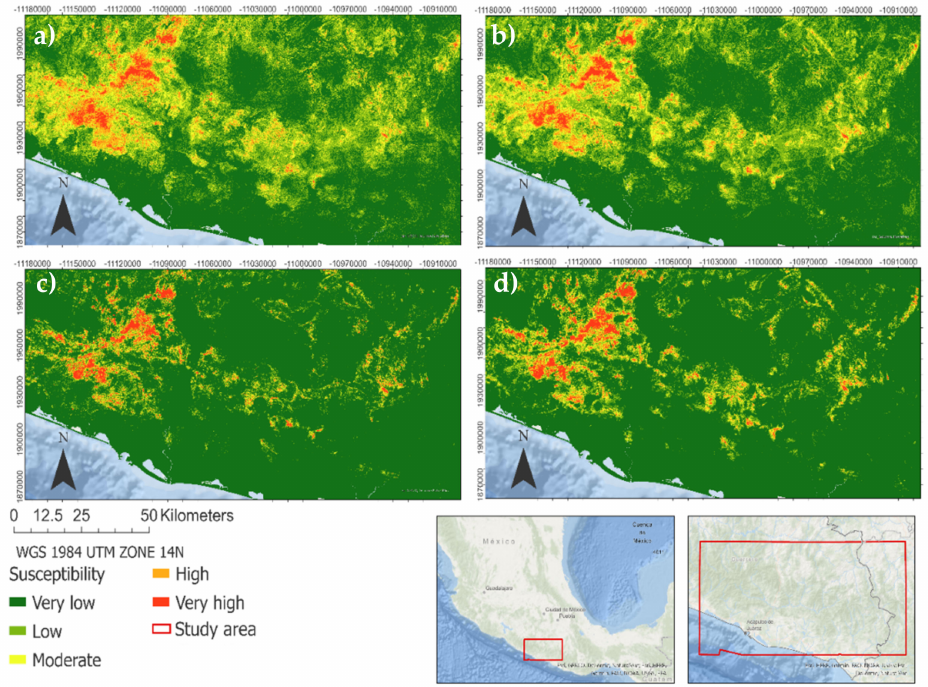
Figure 9. Landslide susceptibility map based on the probabilistic prediction of the ( a ) extra trees, ( b ) random forest, ( c ) extreme gradient boosting, ( d ) catboost classifier. At the bottom, the figures show the study area location.